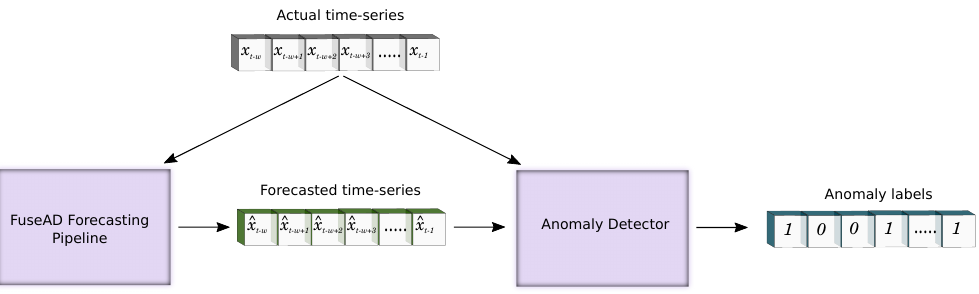
Figure 1. FuseAD overview: The system consists of two modules, the forecasting pipeline and an anomaly